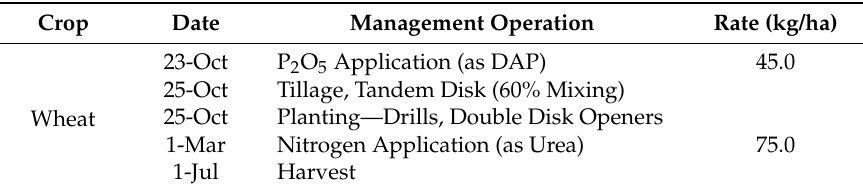
Table 5. Management operations for land in winter wheat production (following corn/soybeans rotation in Table